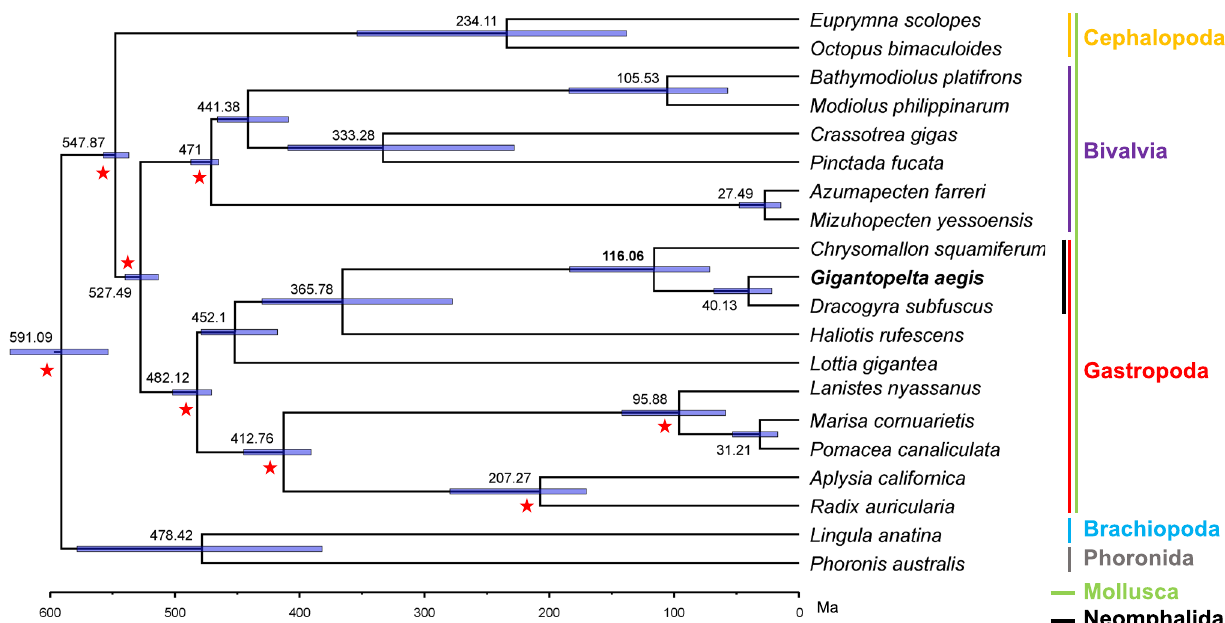
Fig. 3 Divergent time of 20 lophotrochozoan taxa. Time-calibrated phylogeny showing the estimated divergence time of 20 lophotrochozoan taxa, with a focus on 18 molluscs. Phoronis australis (Phoronida) and Lingula anatina (Brachiopoda) served as outgroups for the molluscs. A total of 529 single-copy orthologues were used. The purple horizontal lines indicate the 95% con fi dence intervals of the divergence times. Full information on genome resources, fossil records, and geographic events used in the time calibrated nodes (red stars) are provided in Supplementary Note 3. The colour labelling scheme of taxa: Cephalopoda: orange; Bivalvia: purple; Gastropoda: red; Brachiopoda: blue; Phoronida: grey; Mollusca: green; and Neomphalida: black. Ma: millions of years